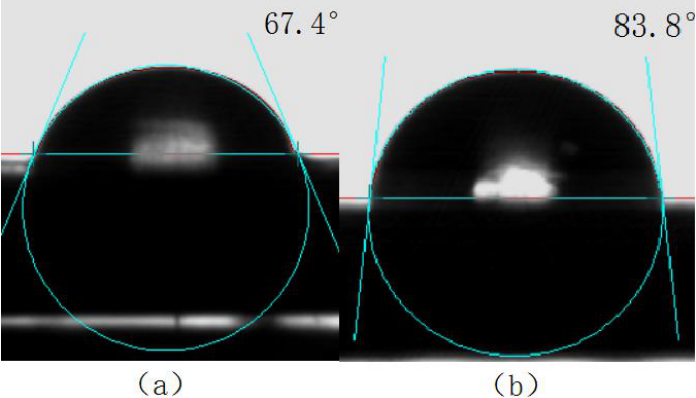
Figure 12. Water contact angle of titanium alloy ( a ) with an ( b ) without laser treatment.